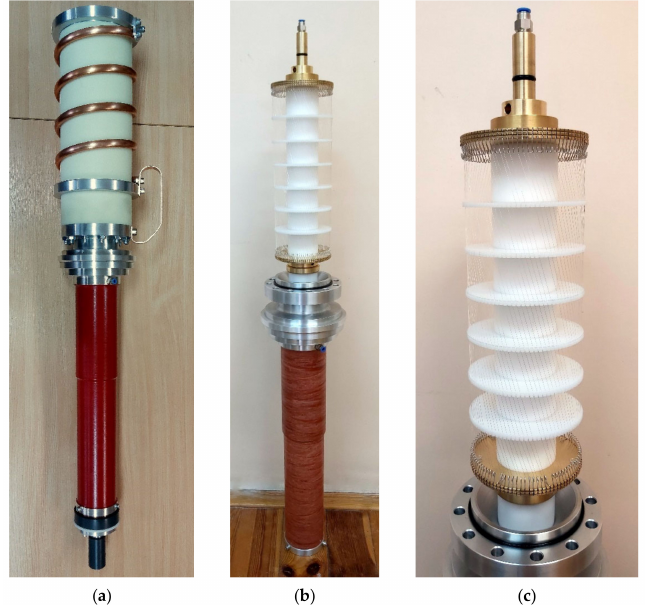
Figure 13. Photographs of the integrated and compact high-power pulse generation and forming system ( a ), along with a view of the inside of the forming fuse compartment ( b , c